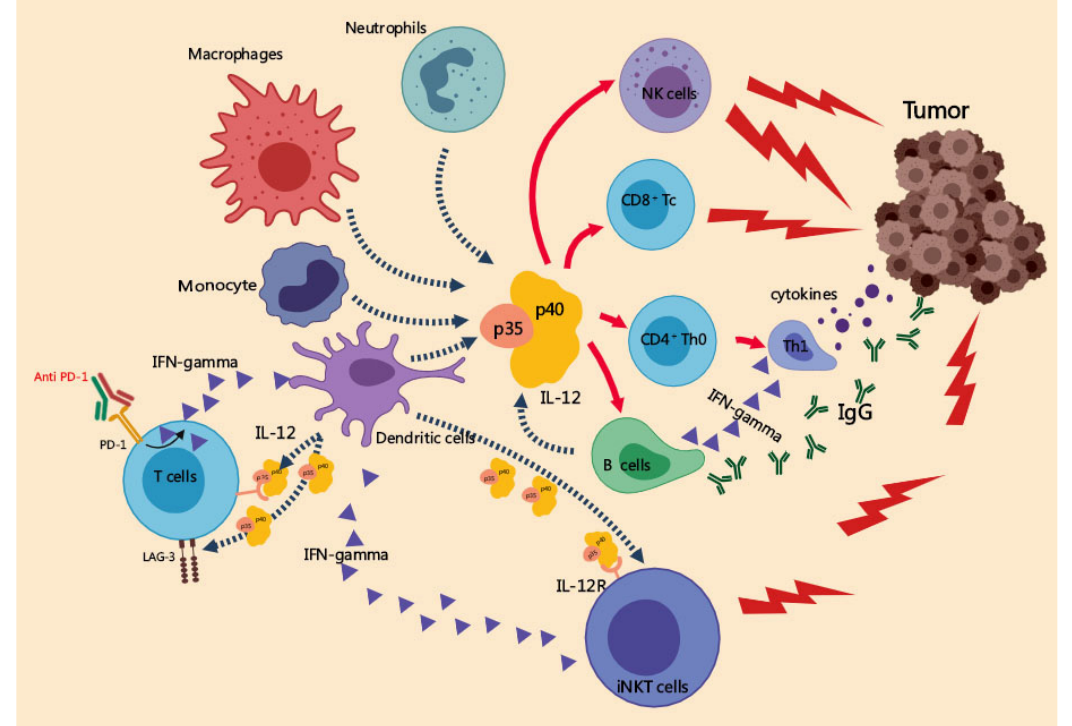
Figure 2. Anti-tumor mechanisms of IL-12. On the one hand, IL-12 secreted by APCs promotes the polarization of Th1 cells and the cytotoxic activity of CD8 + T cells, NK cells, and NKT cells. On the other hand, IL-12 inhibits the differentiation of Tregs and the expression of PD-1, LAG3 in activated T cells and the PD-L1 on tumor cells, thereby preventing the cytotoxic T cells from negative feedback inhibition.